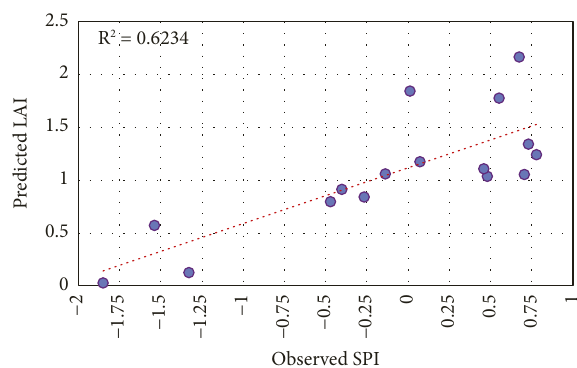
Figure 4: Relationship between predicted LAI to observed SPI.